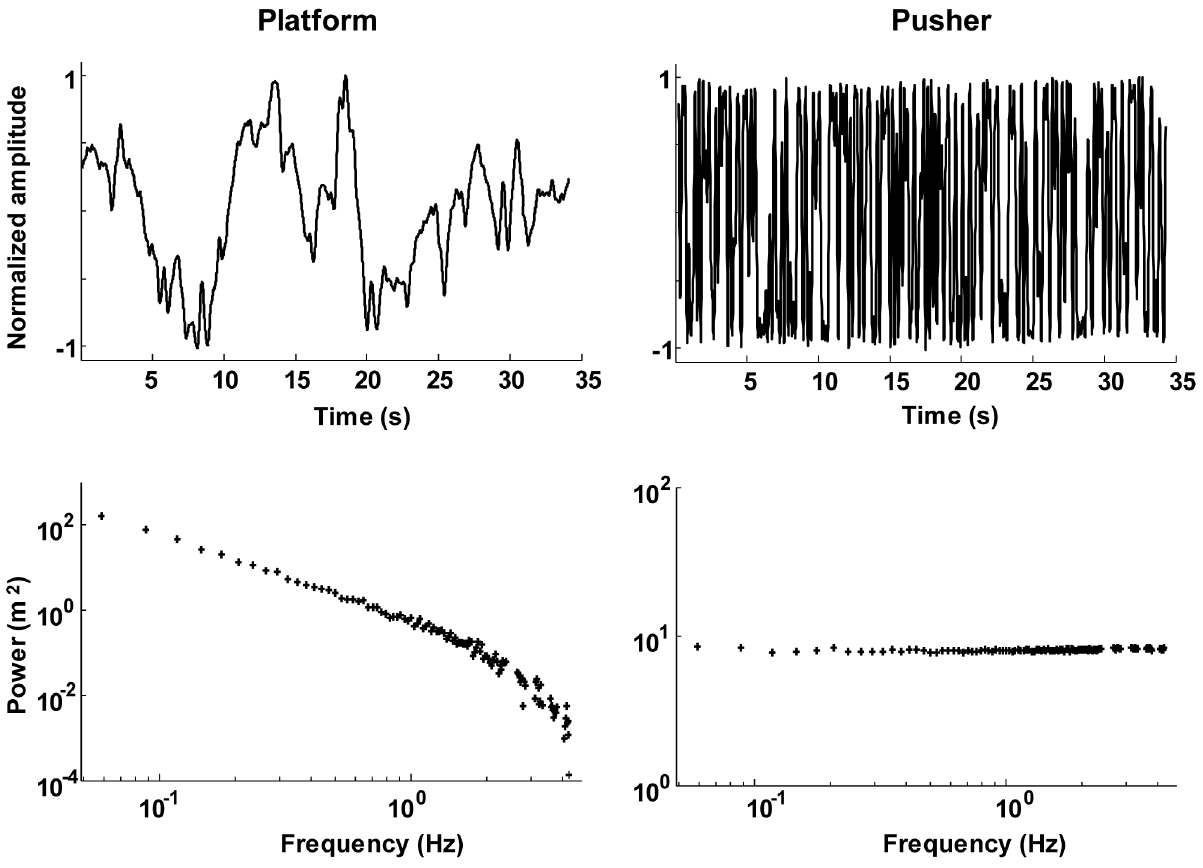
Figure 2. Timeseries and powerspectrum of the two perturbation signals. The left panels represent the platform perturbation; the right panels the pusher perturbation.